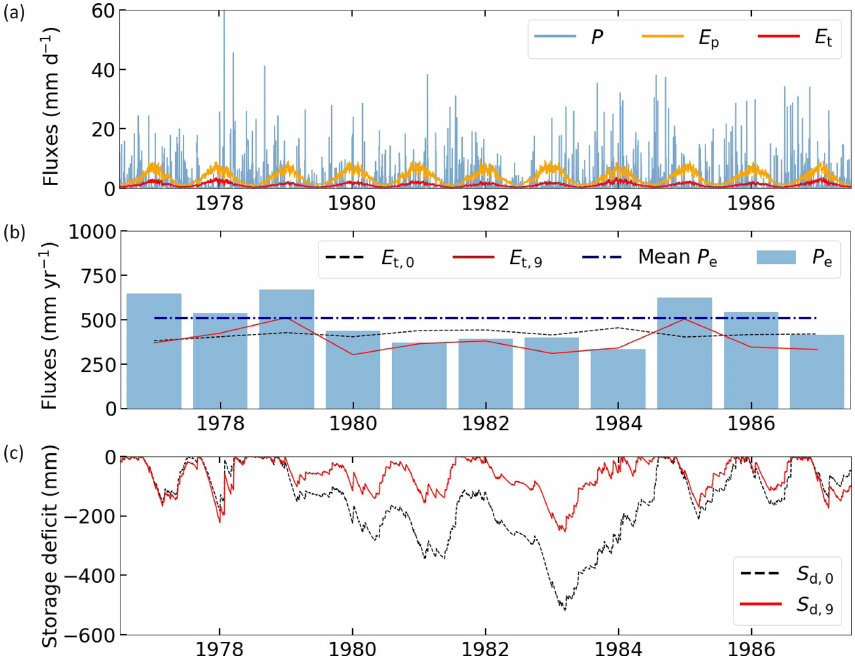
Figure A1. Storage deficit iteration approach in a temperate catchment for the time period 1977–1987. (a) Daily water fluxes with P representing precipitation, E p potential evaporation and E t the initial transpiration calculation based on Eq. (7). (b) Annual water fluxes with P e representing effective precipitation, E t,0 the initial transpiration estimate and E t,9 the final iteration transpiration estimate. Mean P e is based on the full time period (1973–2010). (c) Daily storage deficit with S d,0 representing the initial calculation and S d,9 the final